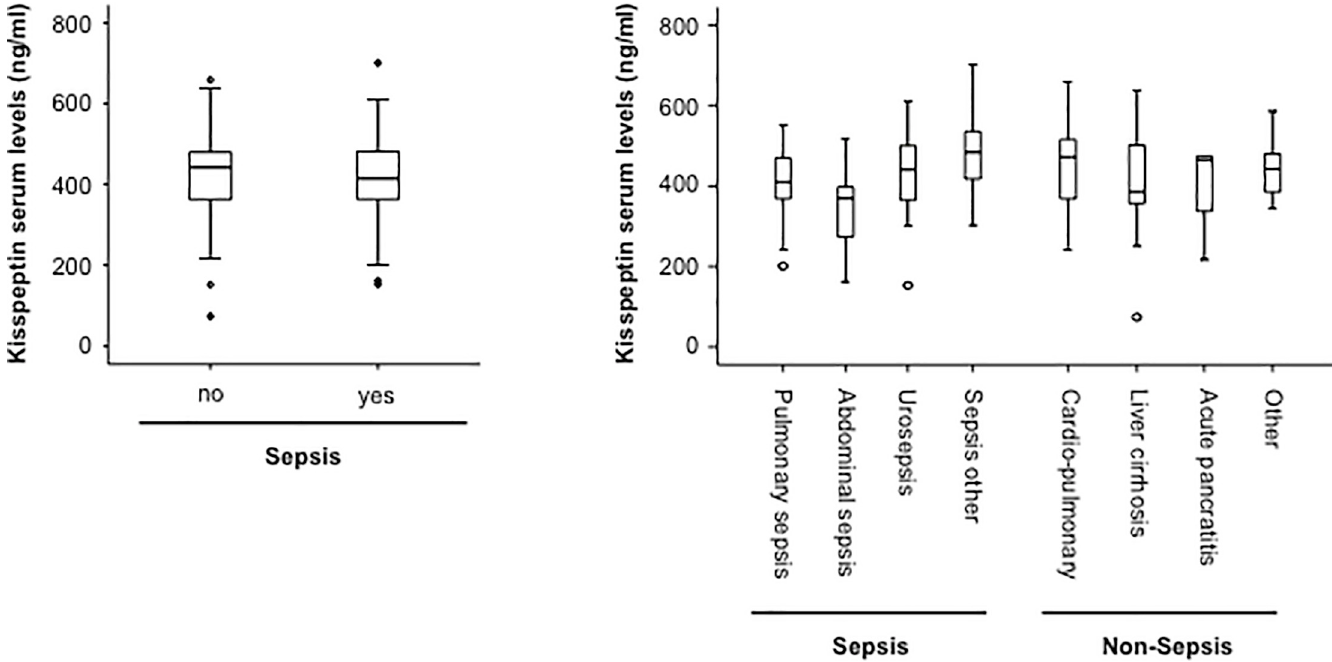
Fig 2. Kisspeptin serum concentrations in patients with sepsis. (a) ICU patients with sepsis (n = 94) displayed similar kisspeptin serum levels compared to patients that did not fulfill the sepsis-3 criteria (n = 39, U-test). (b) Levels of circulating kisspeptin were not altered in patients with different etiologies of critical illness.